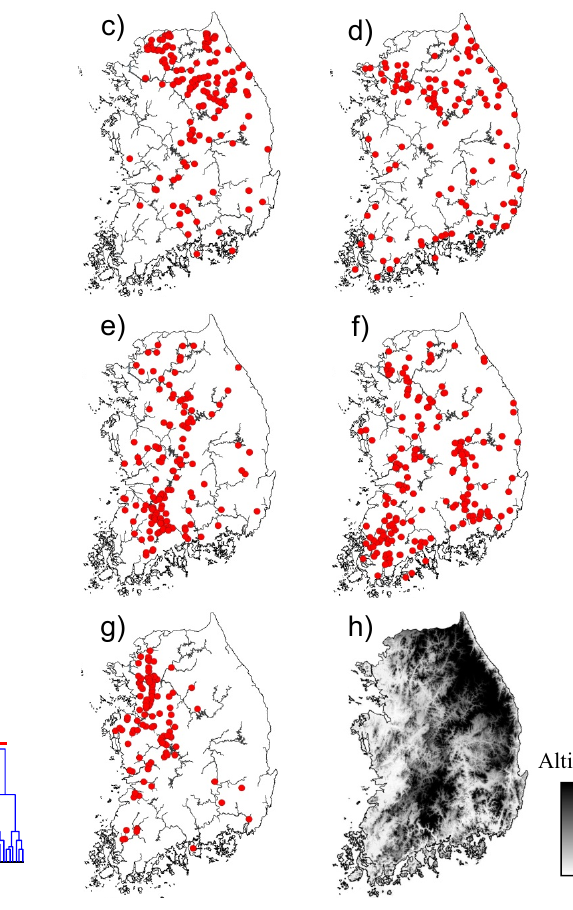
Figure 3. ( a – b ) Classification of 691 samples into five clusters (I–V) through the training of self-organizing map (SOM) and ( c – g ) the geographical distribution patterns of the sampling sites in five clusters, and ( h ) a digital elevation map (DEM) for comparing the relative elevation of each